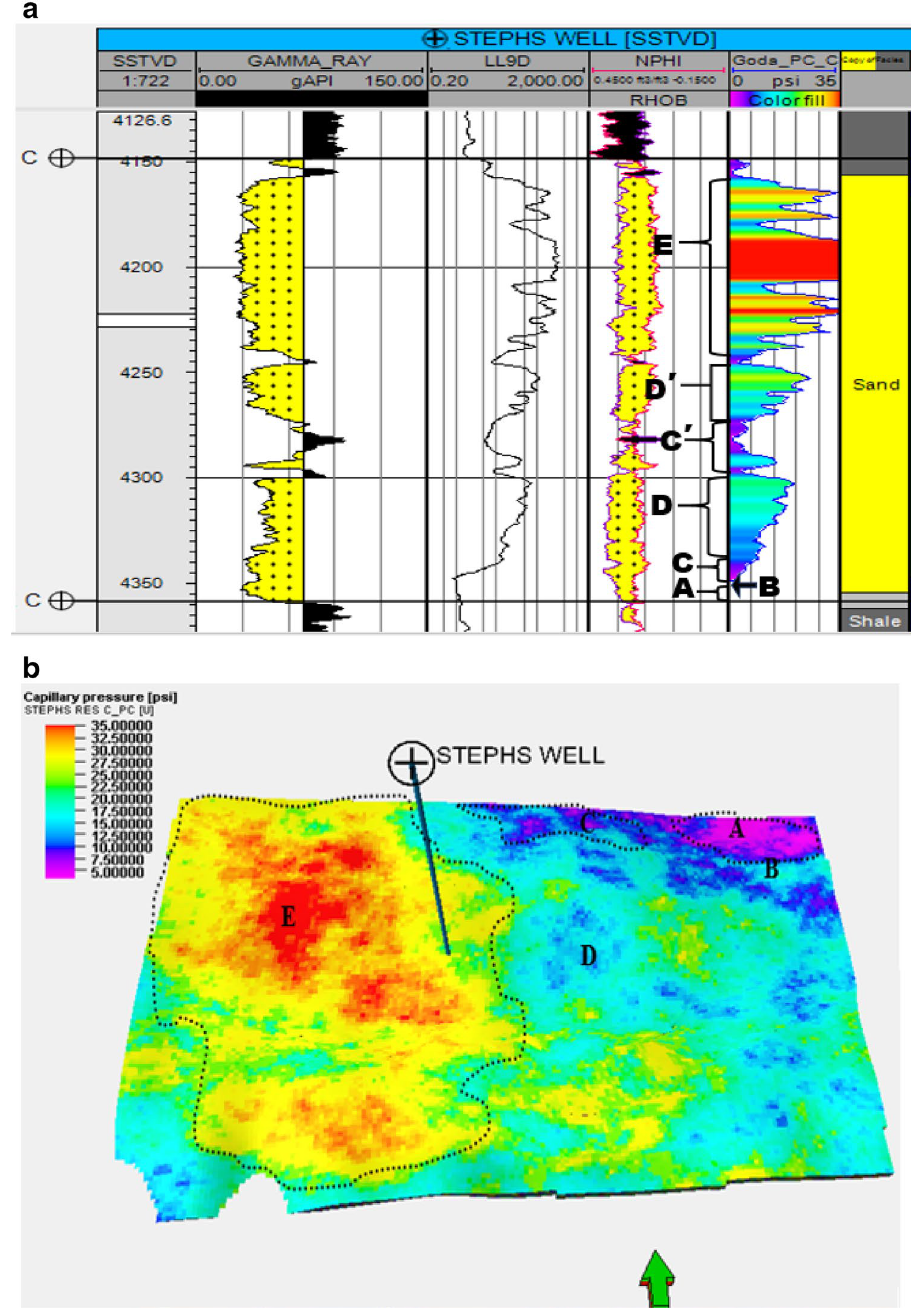
Fig. 13 a Well section with cap- illary pressure log for reservoir C. A is FWL, B is OWC, C & C’ is entry pressure, D & D’ is transition zone, E is the zone fully saturated with hydrocar- bon. b Capillary pressure model for reservoir C (A is FWL, B is OWC, C is low-P c zone, D is transition zone and E is the zone fully saturated with hydrocar-